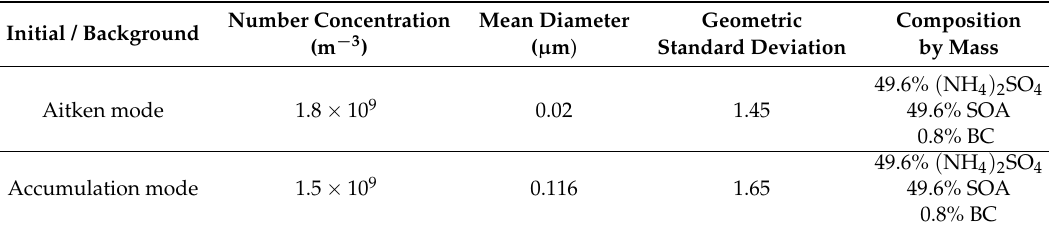
Table 3. Size distribution and composition of initial conditions and background aerosols prescribed in